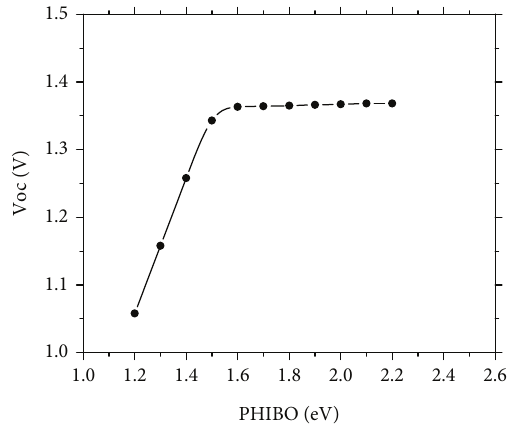
Figure 3: PHIBO versus Voc plot of the proposed solar cell ’ s front contact.